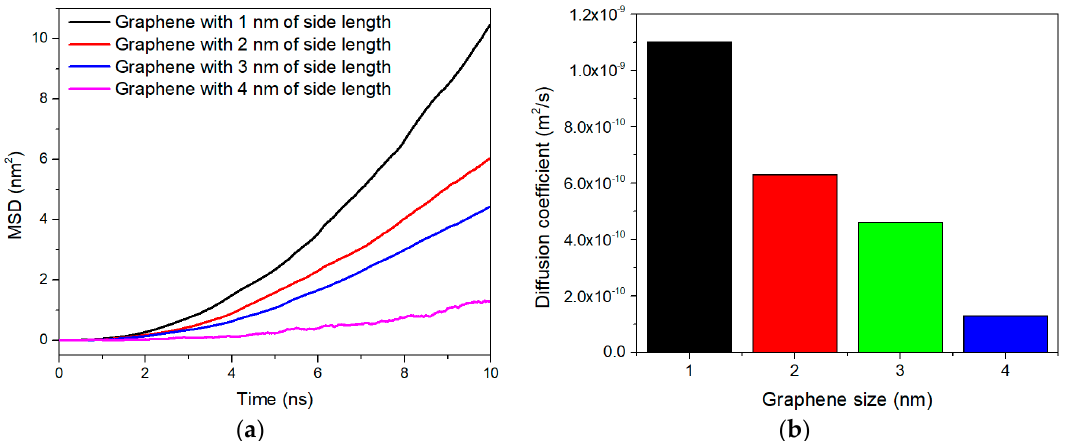
Figure 4. ( a ) MSD curves and ( b ) diffusion coefficients of graphene with various sizes at 300 K and 0.1 MPa. 0.1